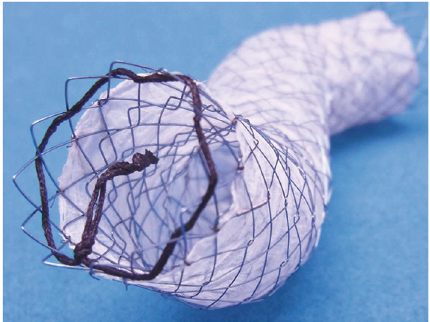
Figure 1: Partially covered Niti-S stent (Taewoong Medical) 10cm long with a diameter of 16 mm. The partially covered stent is uncovered at both ends over a distance of 0.5cm. This stent is able to maintain a three-dimensional form.